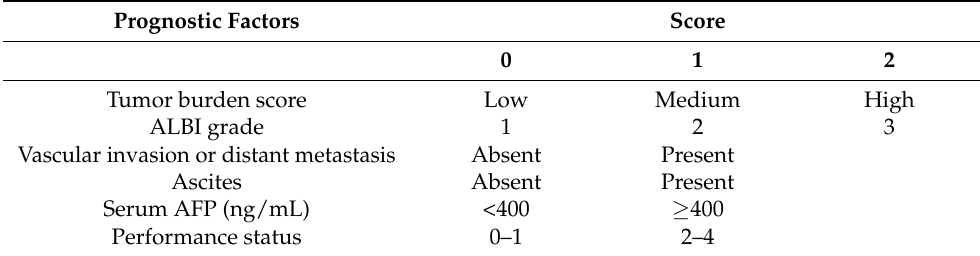
Table 3. The TBS–ALBI system.